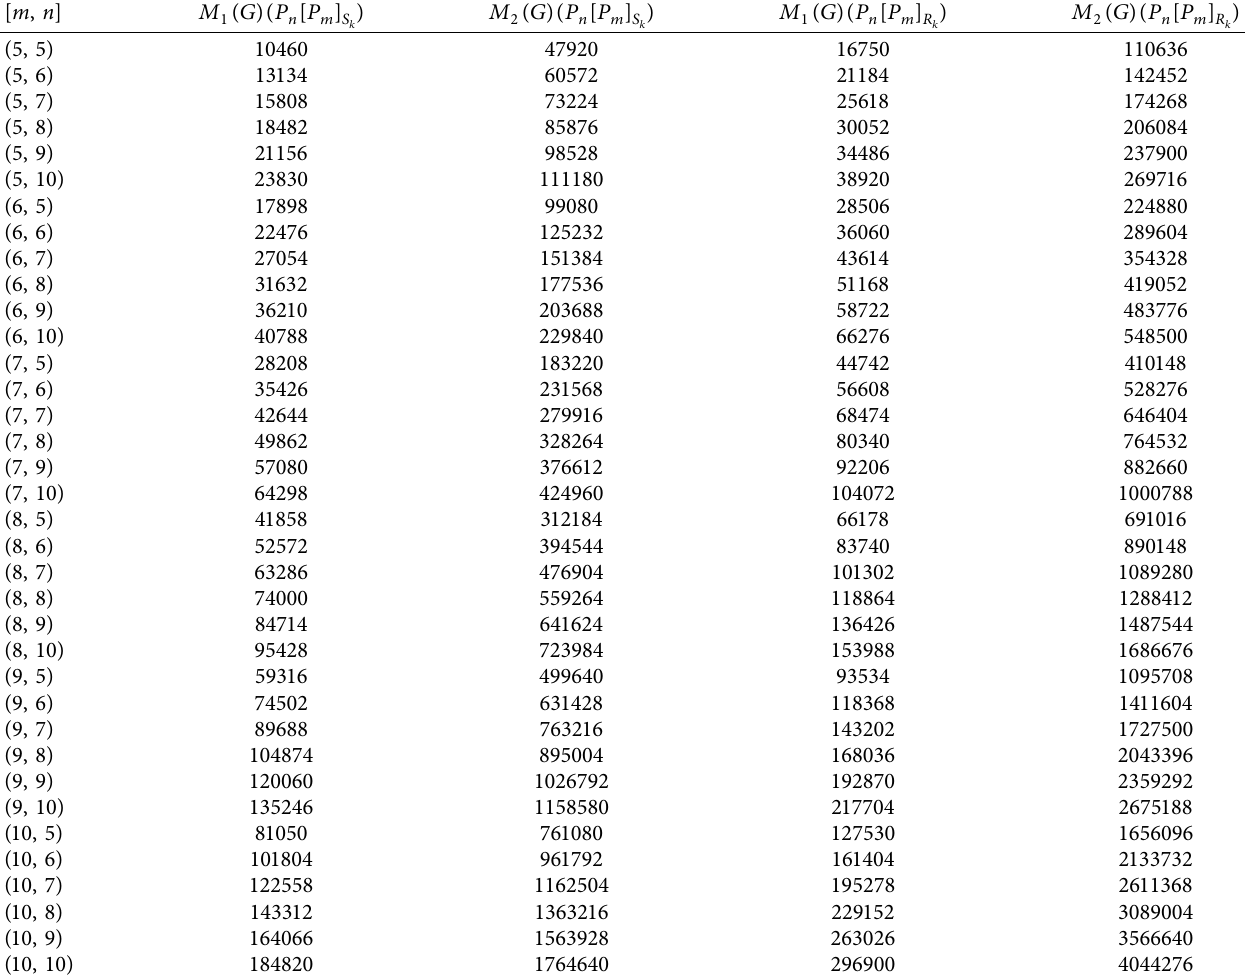
[ P ] ) for k � n m N k